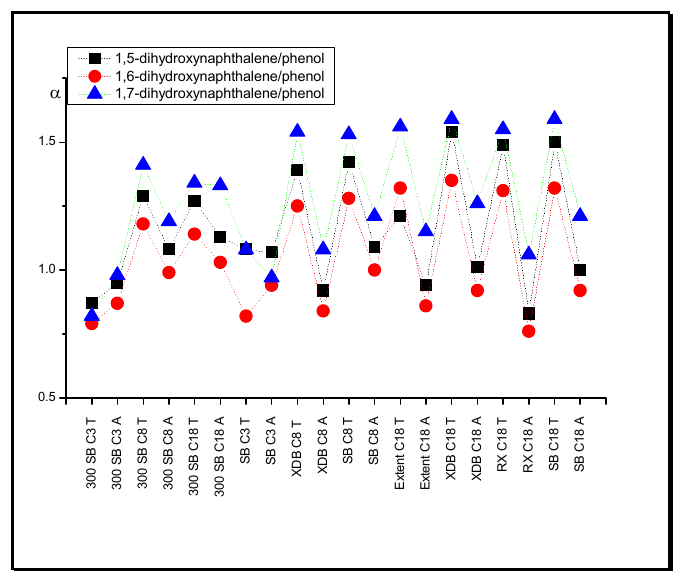
Figure 1. Separation factor, α , values of dihydroxynaphthalenes relative to phenol in systems with different nonpolar stationary phases and acetonitrile (A) in water and tetrahydrofuran (T) in water (modifier concentrations as in Table 1).